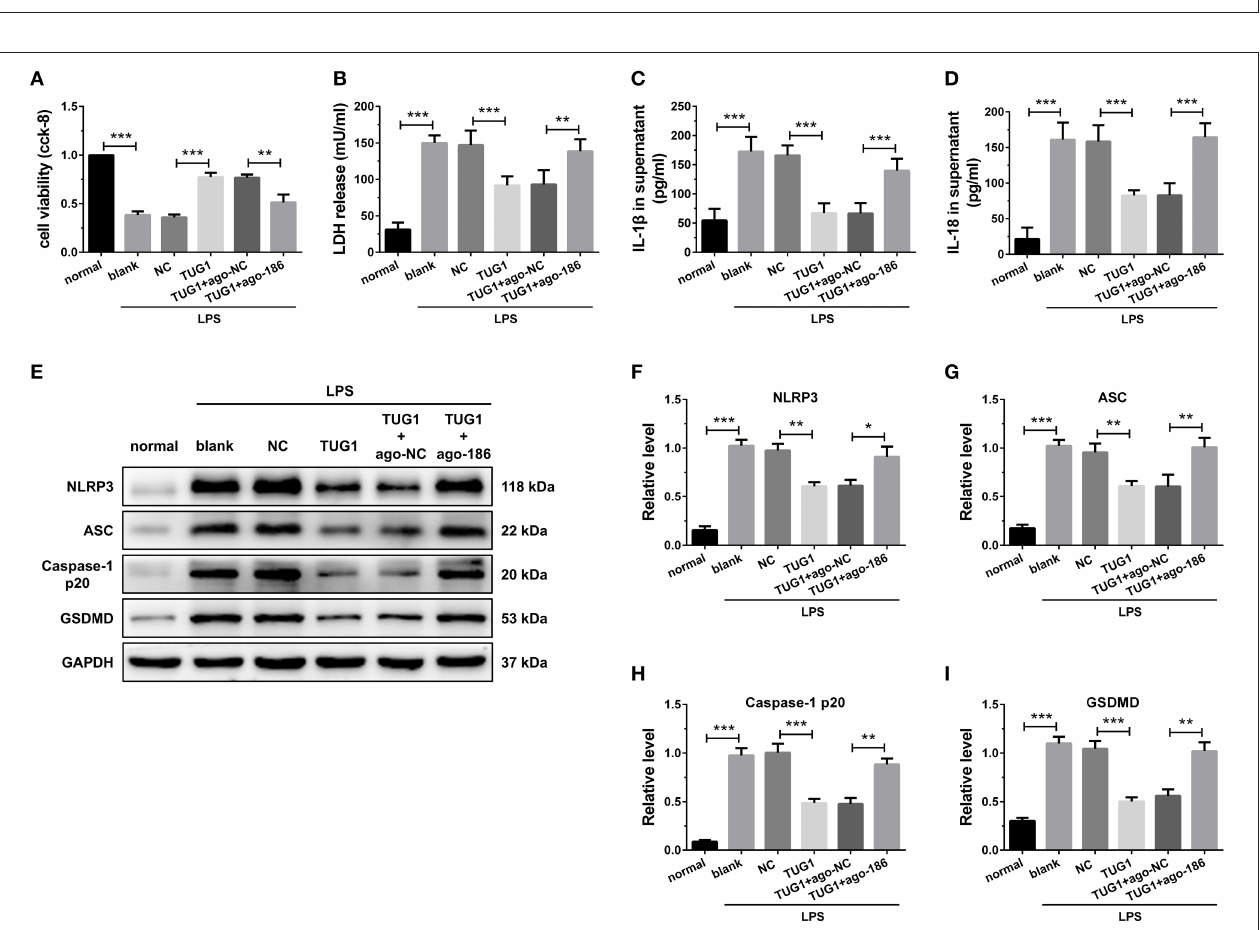
FIGURE 4 | with qRT-PCR ( n = 10). (I) RIP assay was carried out to demonstrate the combination between TUG1 and miR-186-5p. (J) Pulldown assay was applied to prove the binding relation between TUG1 and miR-186-5p. (K) LVEF was assayed by echocardiography ( n = 10). (L) HBFP staining was used to measure micro infarct size ( × 200; scale bar = 50 µ m) ( n = 10). (M) cTnI parameters for rats in each group ( n = 10). (N) Western blotting was used to quantify myocardial NLRP3, ASC, caspase-1 p20, GSDMD, IL-1 β , and IL-18 protein levels with GAPDH as a normalization control ( n = 3). Data are mean ± SEM from three or more independent